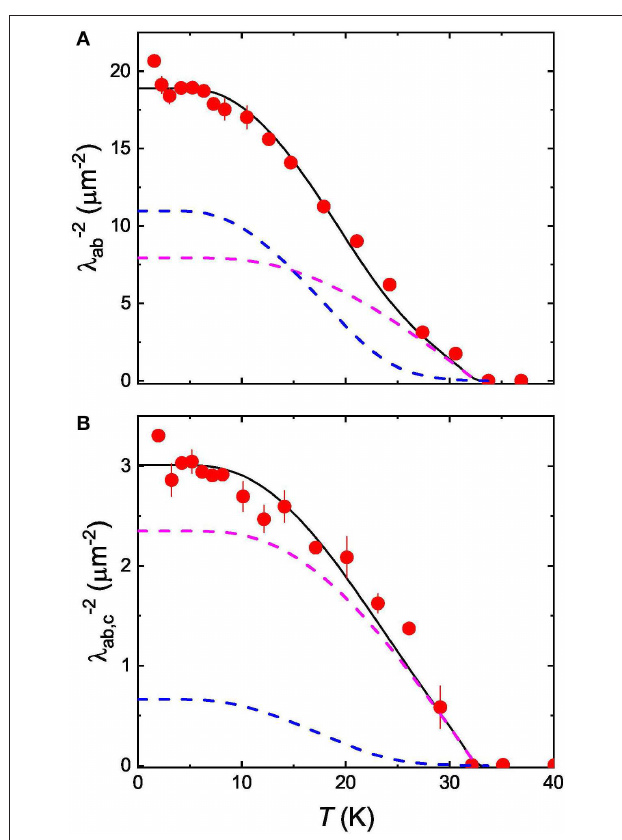
FIGURE 5 | Temperature evolution of the inverse squared magnetic penetration depth of NdFeAsO 0.65 F 0.35 : (A) — λ − 2 ab and (B) — λ − 2 ab , c . Black solid lines are theoretical curves obtained by analyzing the data within the self-consistent two-gap model. The dashed pink and blue lines are contributions of the larger ( 1 1 ), and the smaller ( 1 2 ) gaps to the magnetic penetration depth, respectively. See section 4.1 for